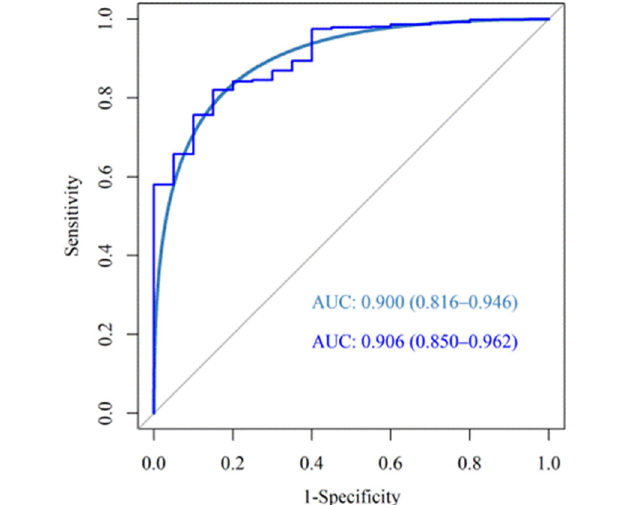
Figure 5. Predictive Ability of a Mixed-Effects Model to Identify Survivors at Risk for Left Ventricular Dysfunction. Receiver operator characteristics curve with smoothing (light blue) and without smoothing (dark blue) is shown. The area under the curve (AUC) for the receiver operator characteristic curve (ROC) generated by our data is 0.906 (95% confidence interval: 0.850–0.962) with an AUC of 0.900 for the corresponding smoothed ROC (95% con fi dence interval: 0.816–0.946).